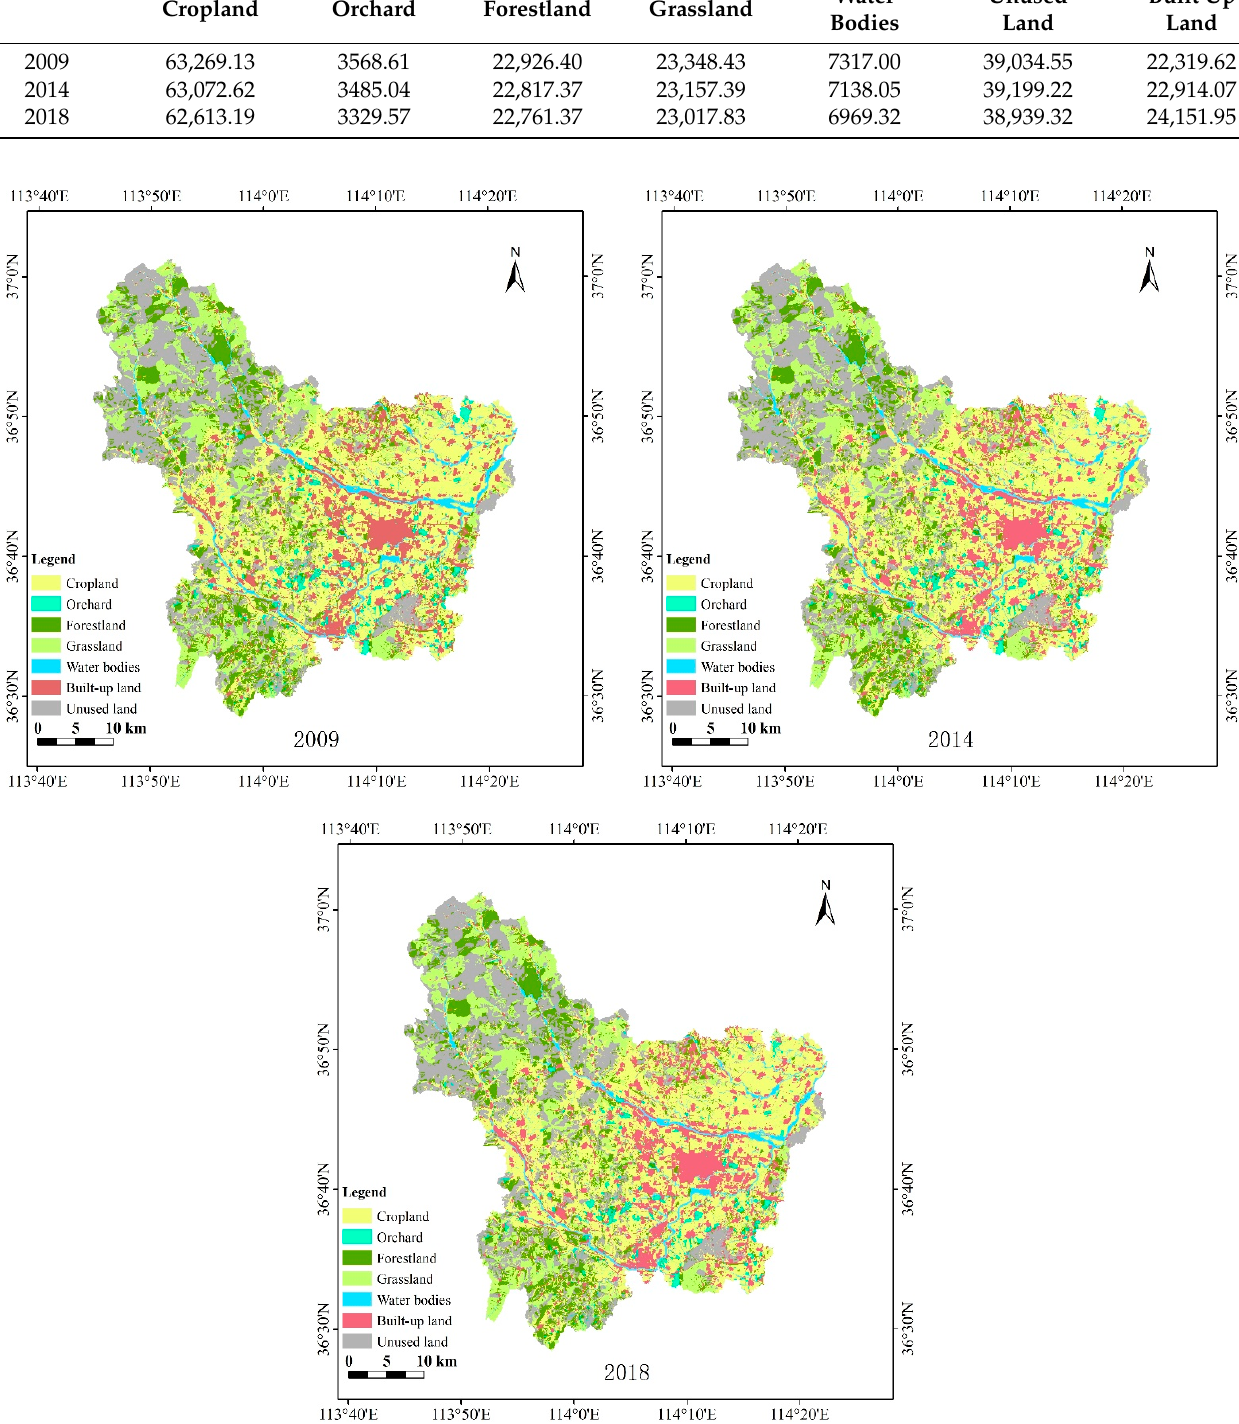
Figure 2. The spatial distribution maps of land-use types during 2009–2018. A 500 m × 500 m fishing net is used to intersect with the study administrative area to form evaluation units. The digital elevation model (DEM) and slope (generated by the DEM) were downloaded from Geospatial Data Cloud (http://www.gscloud.cn/, accessed on 5 December 2021). Grain yield and price data were derived from the Wu’an City Eco- nomic Year Book (2013–2018).